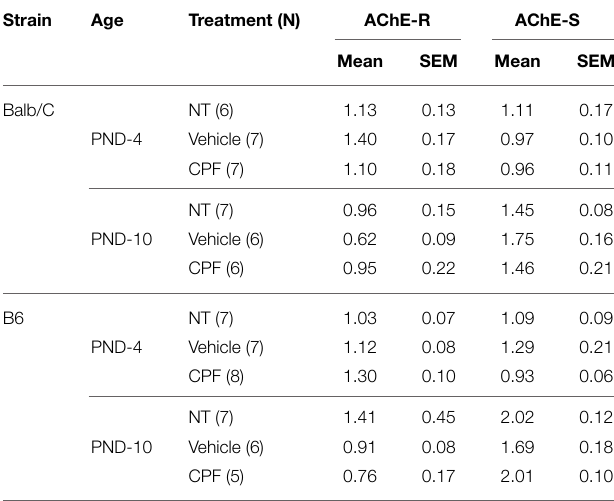
TABLE 1 | Expression of AChE-R and AChE-S transcripts in forebrain of mouse